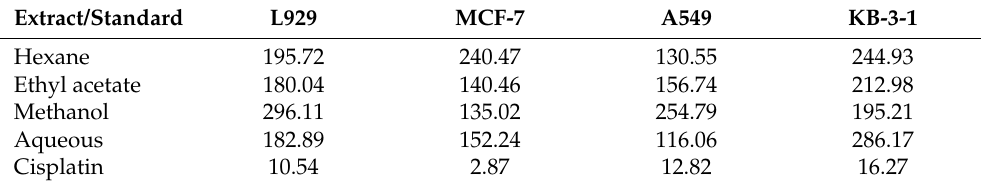
Table 6. IC 50 value ( µ g/mL) of F. arabica extracts against different cell lines.